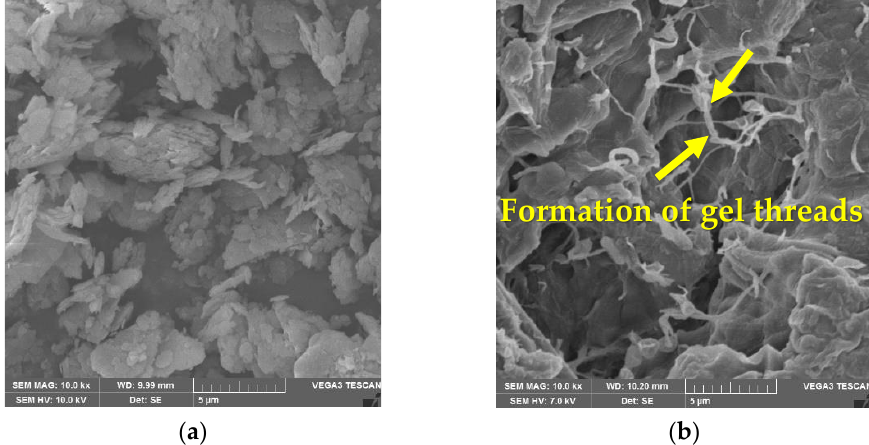
Figure 7. SEM Micrographs. ( a ) Kaolin clay; ( b ) β -glucan-treated kaolin clay.